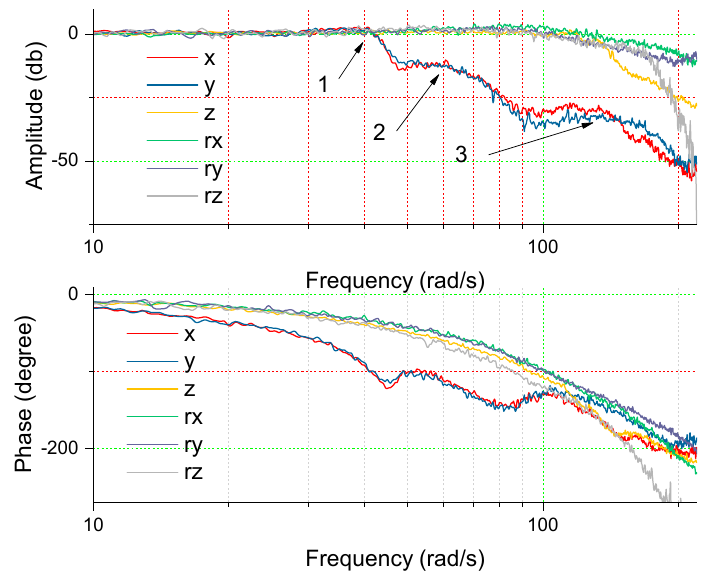
Figure 9. Bode diagram of the experimental platform.